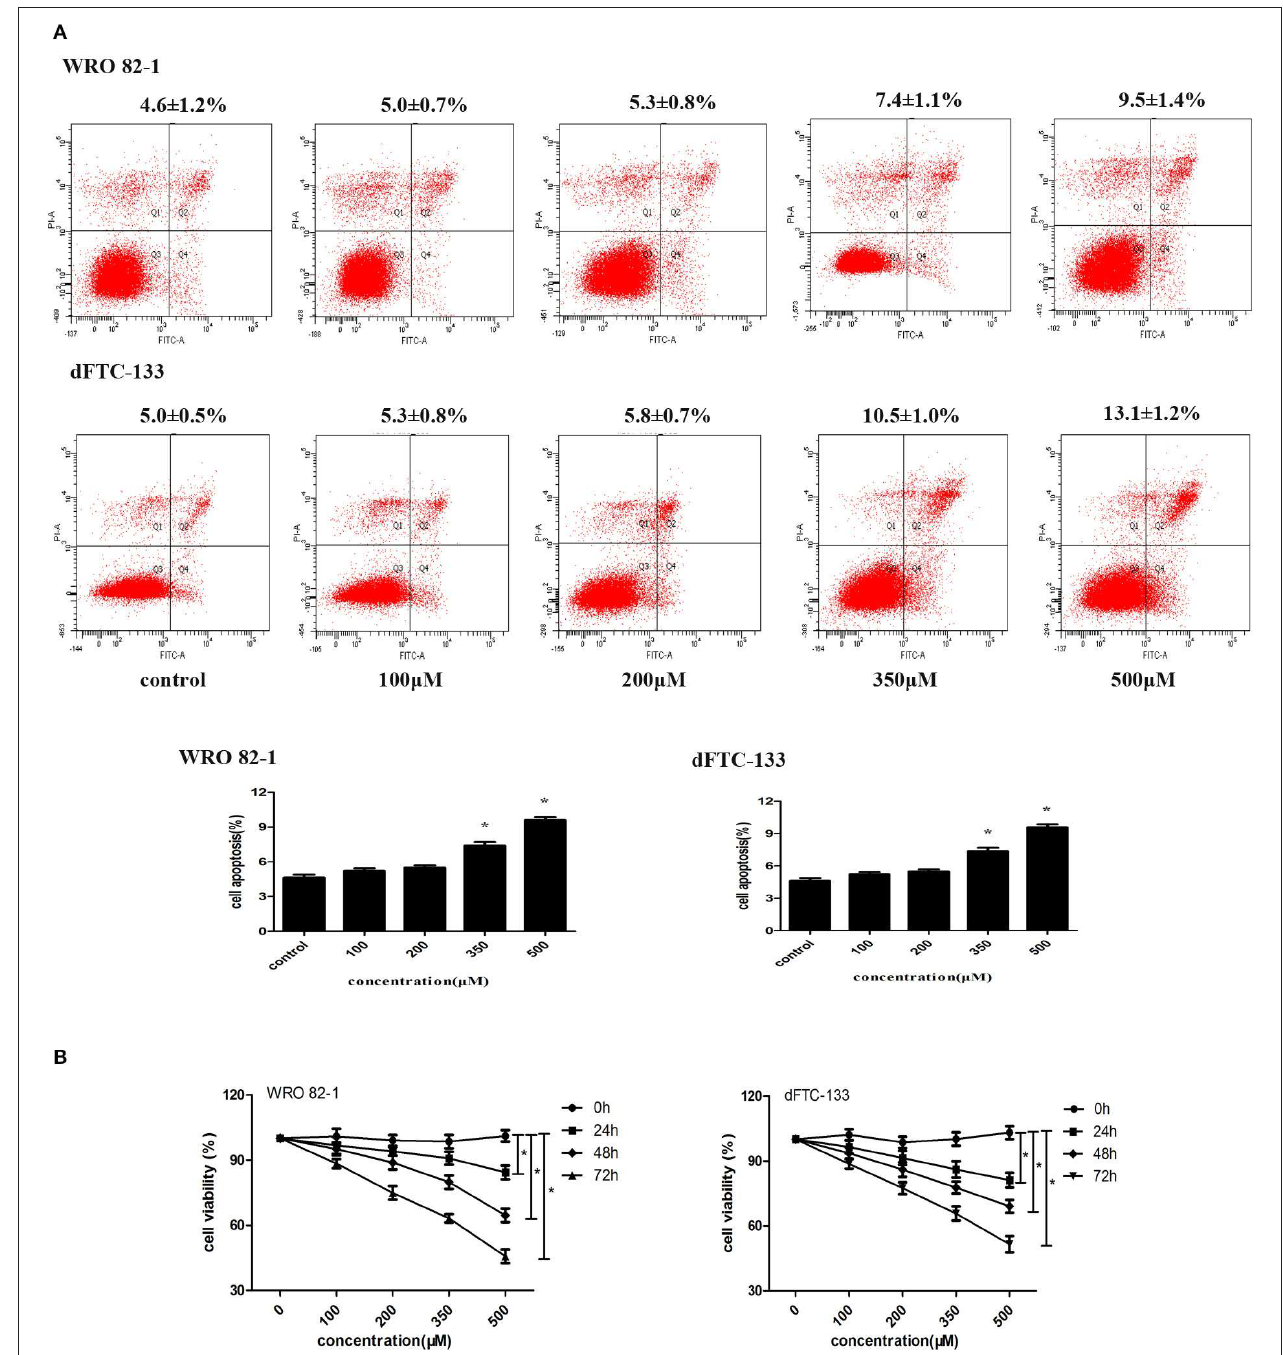
FIGURE 1 | Nevirapine inhibited cell proliferation without inducing apoptosis in dedifferentiated thyroid cancer WRO 82-1 and dFTC-133 cells. (A) The apoptotic cells were detected by Annexin V-FITC and PI staining using flow cytometry. The percentage of apoptotic cells is shown as the mean ± SD of three replicate experiments above the panels. (B) Effects of nevirapine on cell proliferation was monitored by Cell Counting Kit-8 assay. Data are shown as the mean ± SD of three experiments. * P < 0.05 vs. control.